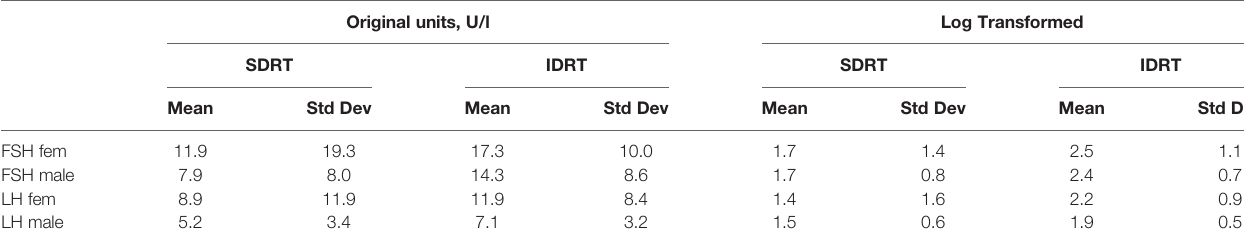
TABLE 2B | Hormone statistics in HD14 according to SDRT vs . IDRT; Standard deviation (Std Dev).